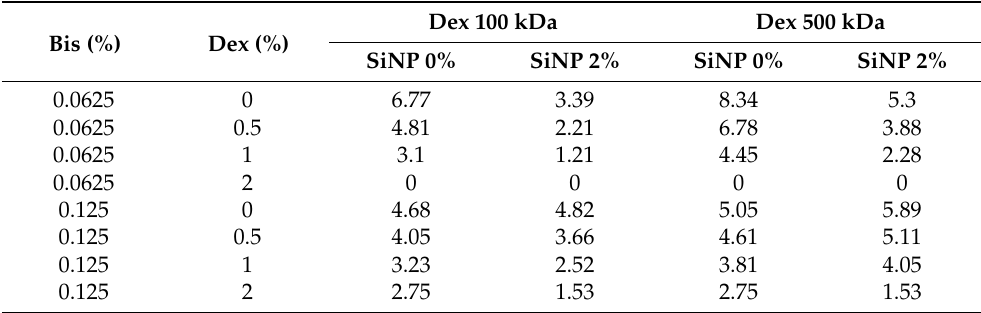
Table 4. ∆ G’ values in units of decibel, computed from transitioning from single to interpenetrating network hydrogel